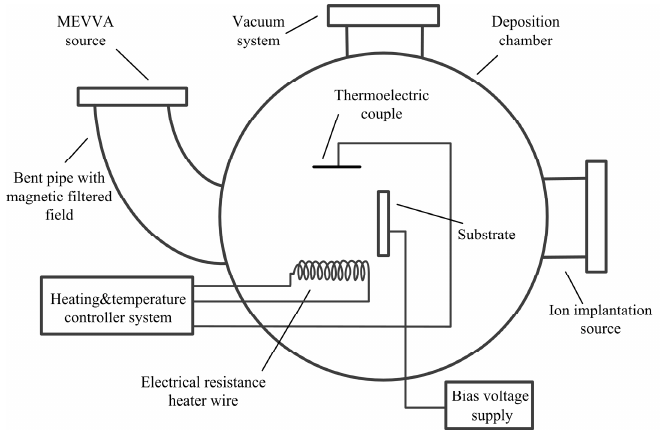
Figure 1. Schematic representation of coatings deposition equipment. Table 1. TiN coatings preparation process and parameters.